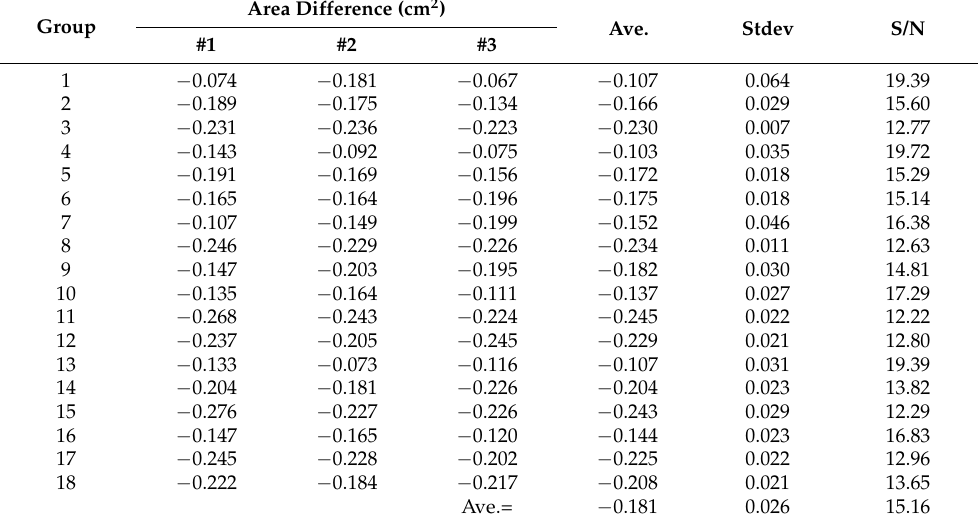
Table 3. The evaluation results obtained from three independent measurements via Equation (6). The area difference is defined as the difference between the practical survey and the theoretical survey (0.5 cm 2 ). The stdev values are the standard deviations obtained in each group from three trials.